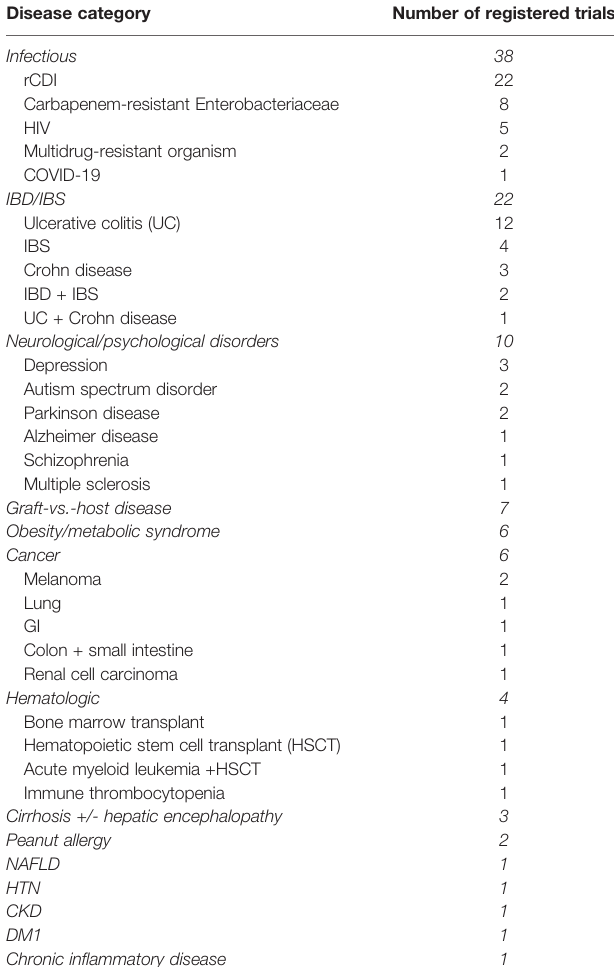
TABLE 4 | Compilation of registered cFMT trials by disease